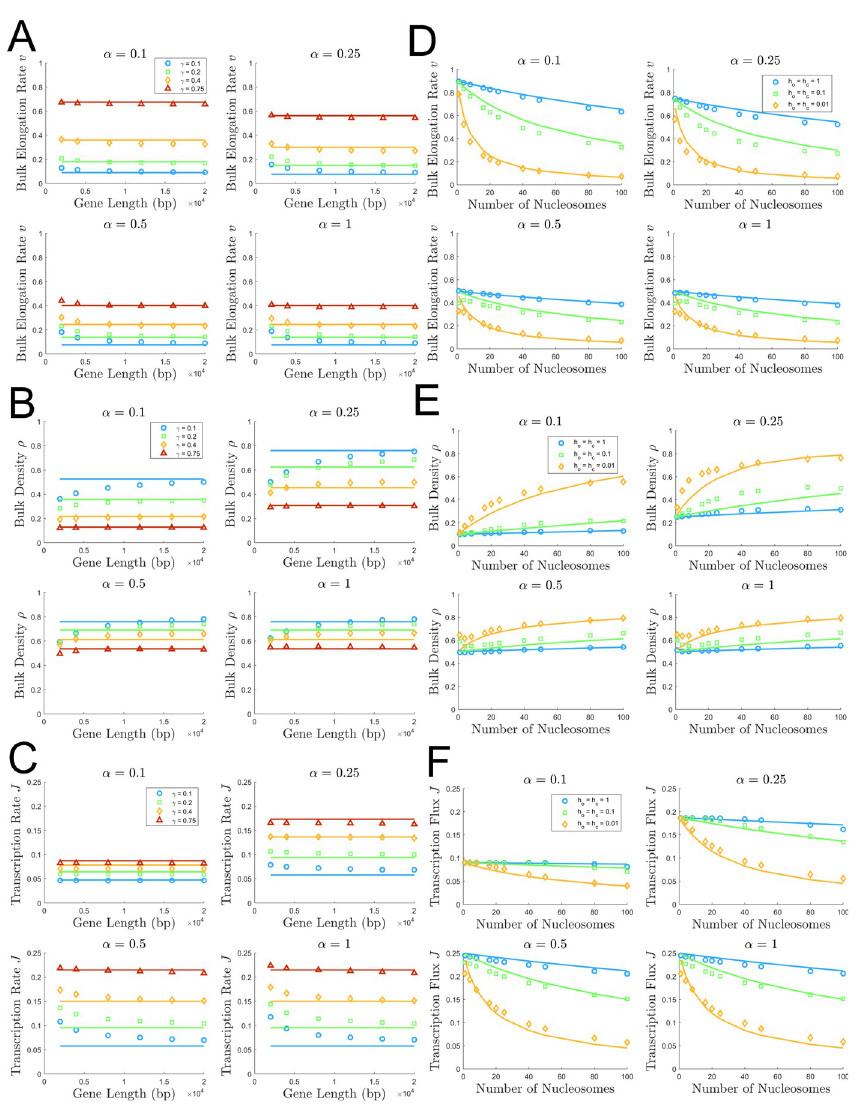
Fig 6. Evaluation of the effects of gene length and nucleosome spacing on bulk transcriptional properties. Panels A ( v ), B ( ρ ), and C ( J ) show the results of a parameter sweep with respect to gene length from 2,000 to 20,000 bp with α = 0.1 (top left), 0.25 (top right), 0.5 (bottom left), and 1 (bottom right), and γ = 0.1 (blue), 0.2, (green), 0.4 (orange), and 0.75 (red). Panels D ( v ), E ( ρ ), and F ( J ) show the results of a parameter sweep with respect to the number of evenly spaced nucleosomes (by varying number of linker sites) giving N 2 {1, 4, 8, 16, 20, 25, 40, 50, 80, 100} with α = 0.1 Nuc (top left), 0.25 (top right), 0.5 (bottom left), and 1 (bottom right). Since γ depends on geometry, h o and h c were set equal to 1 (blue), 0.1 (green), and 0.01 (orange). Both sweeps were performed with 2 × 10 6 Monte Carlo steps and 50 replicates.